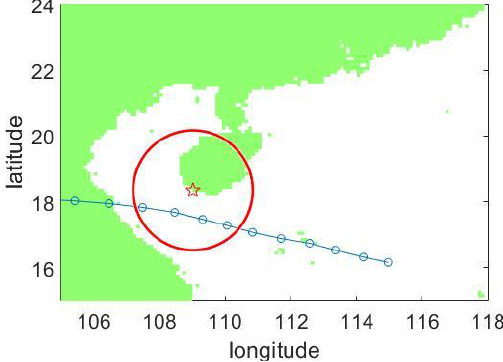
Figure 3. The paths of the designed typhoon.